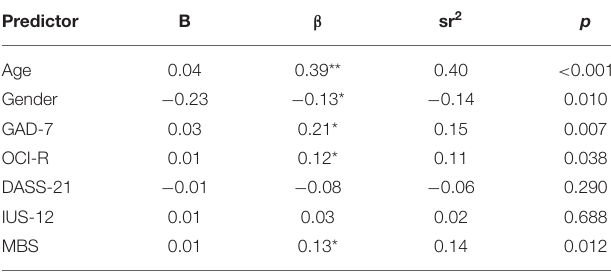
TABLE 6 | Linear Regression Predicting Prepping Beliefs as measured by the PAPBS ( n = 373). Predictor